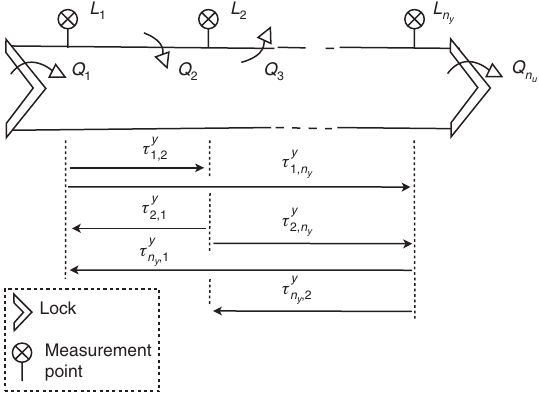
y between Each Measurement , i j